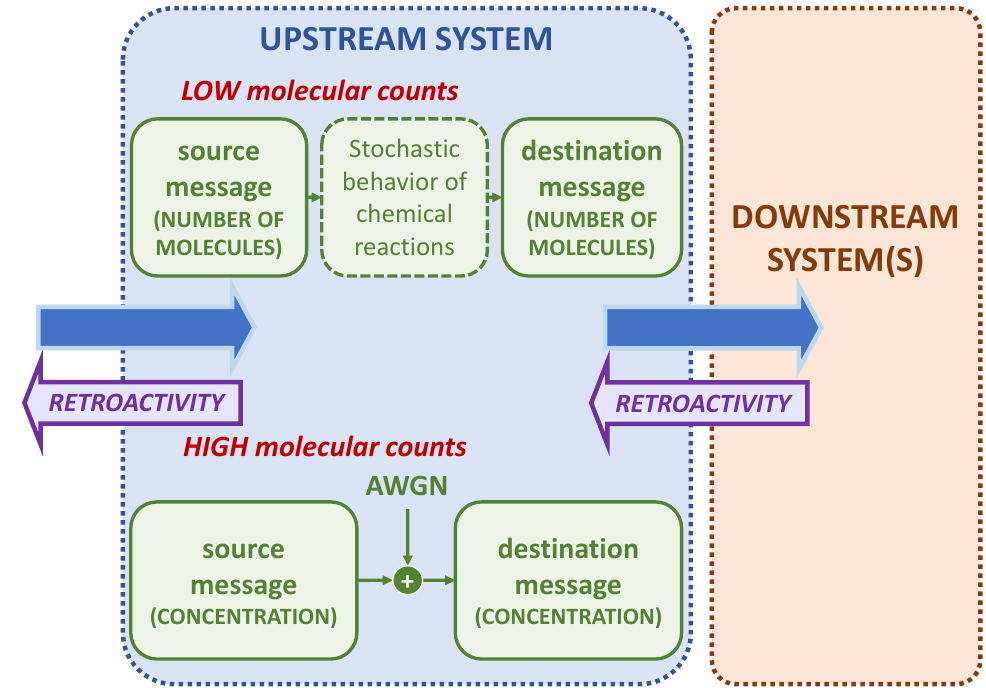
Figure 2. Upstream signaling system in the case of low and high molecular counts. The intercon- nection between the upstream and the downstream system generates the signal going from right to left in the figure (mauve arrow), that is the effect of retroactivity. The blue arrow from left to right represents the signal transmitted throughout the